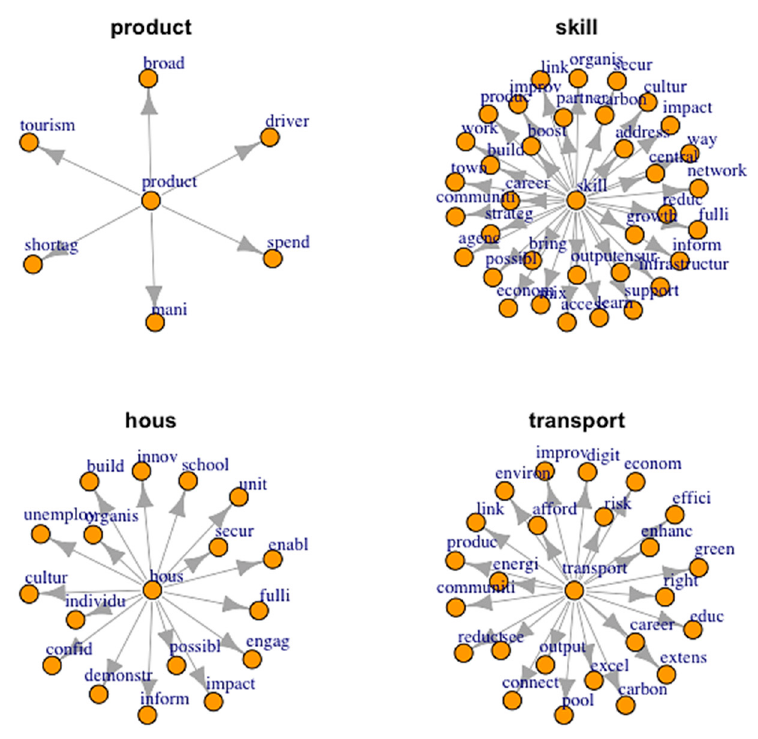
Figure 2. Highly correlated words in strategic economic plan (SEP) documents.